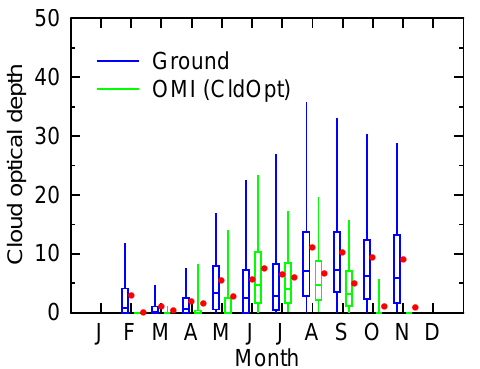
Figure 12. Box-whisker plot of cloud optical depth retrieved from ground-based measurements (blue, left of month marker) and the corresponding CldOpt data set from OMI (green, right of month marker) at Barrow. The averages for both data sets are indicated by red